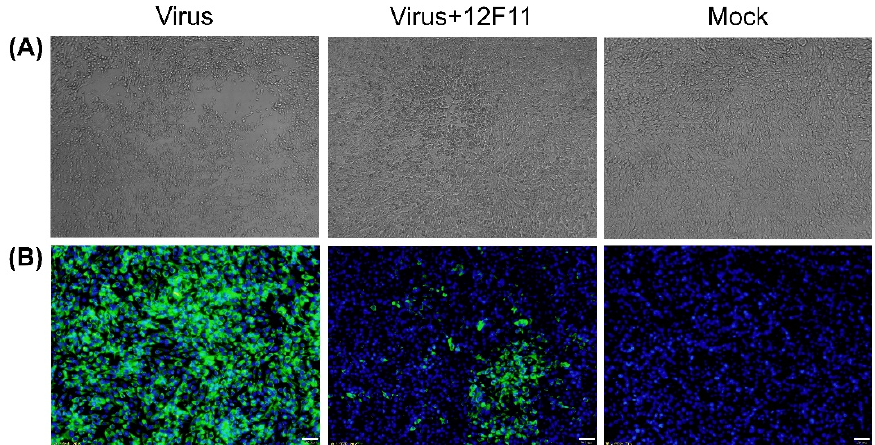
Figure 3. Investigation into 12F11-mediated neutralization. ( A ) Characterization of neutralizing activity of 12F11 using virus neutralization tests conducted in BHK-21 cells. The cells were observed for CPE at 70 h after inoculation with TMUV Y (Virus), TMUV Y plus 12F11 mixture (Virus + 12F11), and maintenance medium (Mock). Undiluted ascites was used in virus-antibody neutralization. ( B ) Assessment of neutralizing capacity of 12F11 using IIF assay. Inoculated BHK-21 cells in virus neutralization tests were sampled. The cells were stained with 12F11, FITC-conjugated goat anti-mouse IgG, and DAPI at 36 h after inoculation and viewed with a 20 × magnification. Bar = 20 µ m.